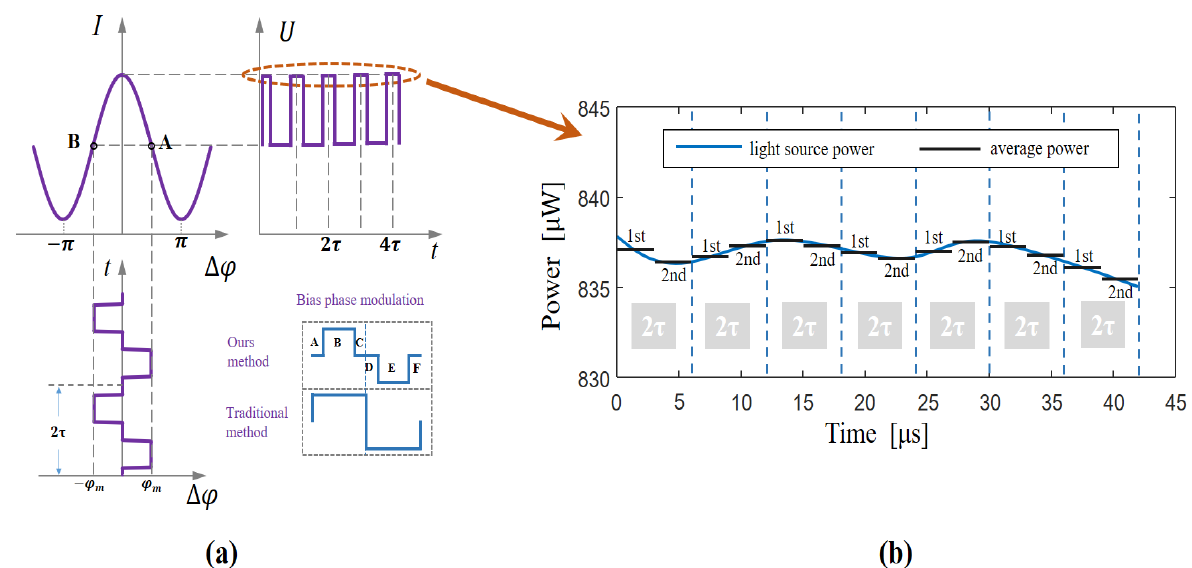
Figure 3. SLD power-demodulation method and SLD power signal. ( a ) Light-source power-demodulation method. In the B and E stage, the bias phase is the same as the traditional method (± φ m ), but in the A, C, D and F stage, the bias phase is set to zero. ( b ) SLD power signal and its discrete signal.